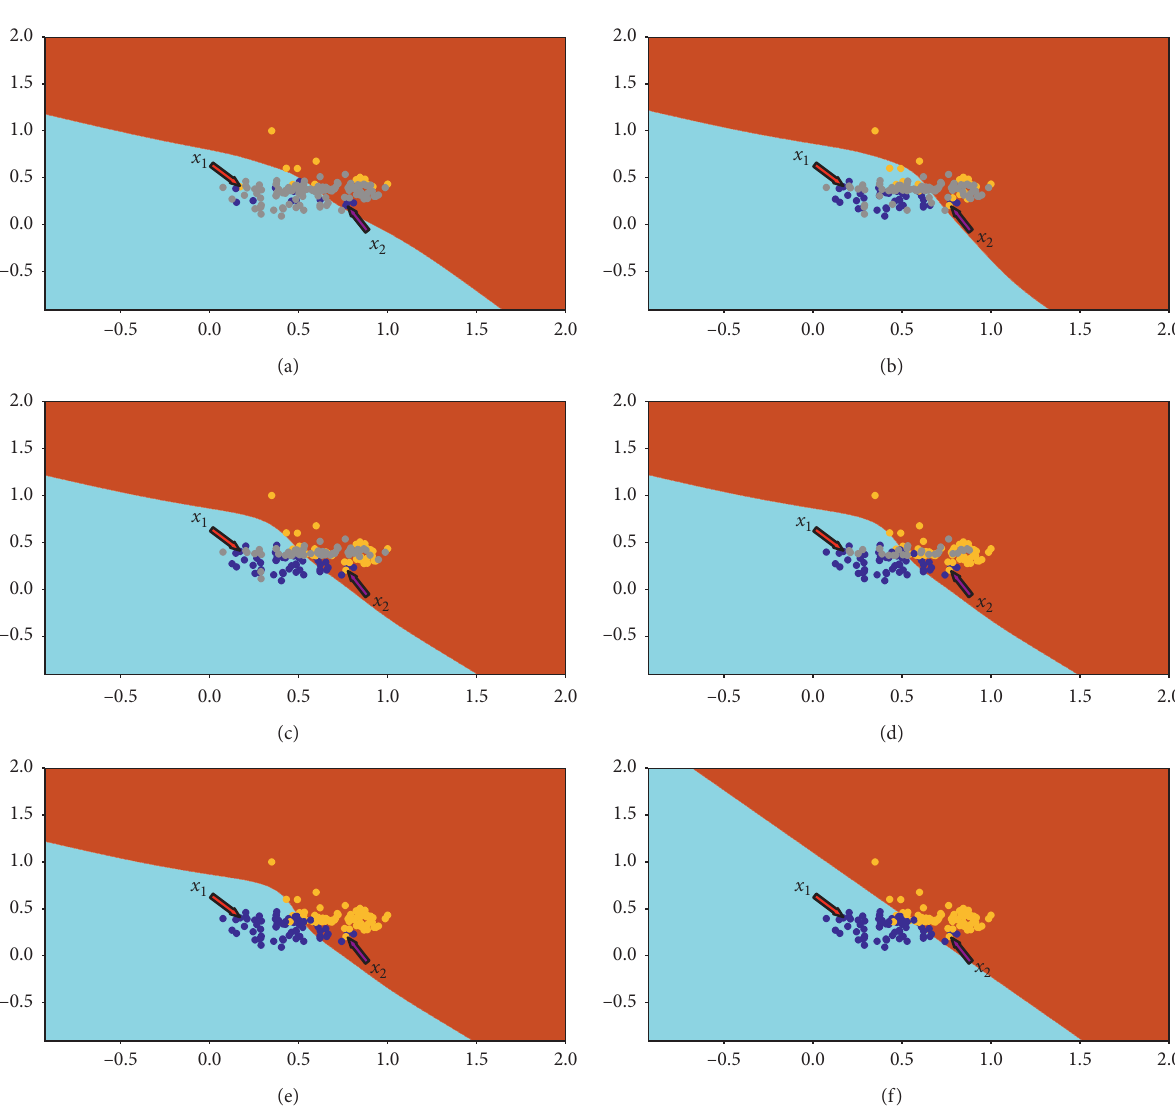
Figure 10: Propagation process. (a) Spreading with 80% unlabelled and 20% labelled, (b) spreading with 60% unlabelled and 40% labelled, (c) spreading with 40% unlabelled and 60% labelled, (d) spreading with 20% unlabelled and 80% labelled, (e) spreading with 100% labelled, and (f) SVC with RBF kernel.